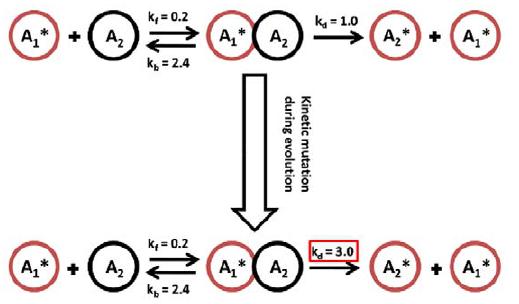
Figure 1. Mutation of kinetics parameters. A (cid:2) active form of the protein A 1 , A 2 another inactive protein molecule, A 2 is the complex formed during the reaction between A (cid:2) A (cid:2) 1 A (cid:2) is the active form of A 2 . k f , k b , and k d are the rates (interaction 2 strength) of the reactions. A mutation of the reaction alters any of the rates, e.g., k d ~ 1 : 0 (top) adopts the new value k d ~ 3 : 0 (bottom). doi:10.1371/journal.pone.0050905.g001 PLOS ONE |